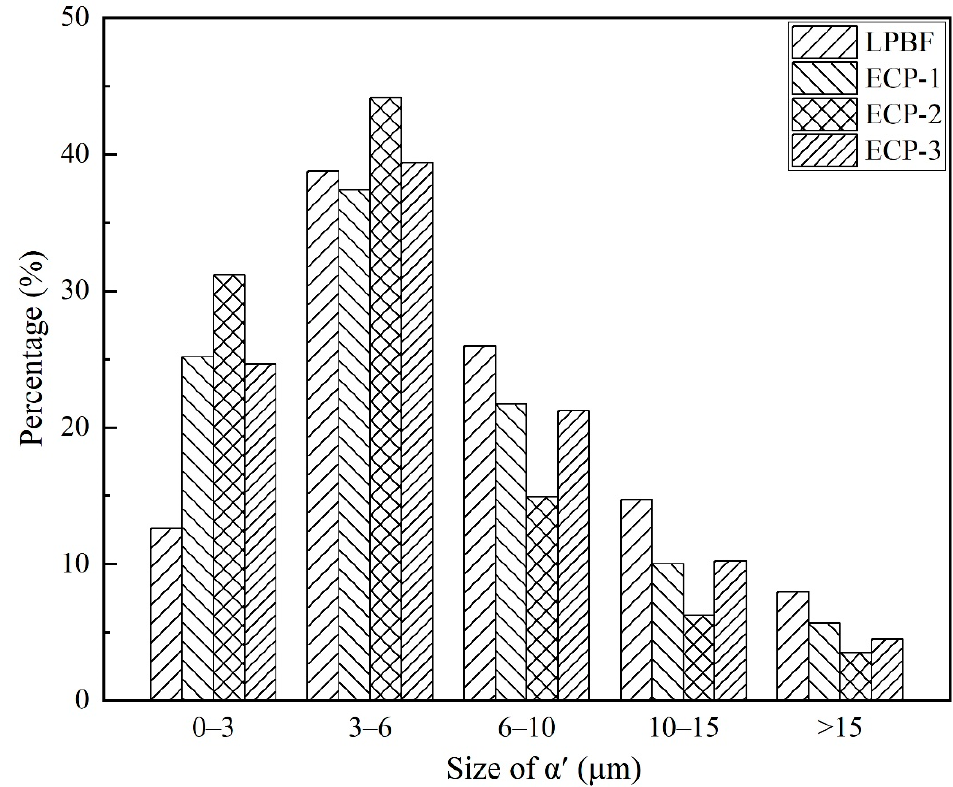
Figure 7. The size distribution of α′ martensites in the LPBF-Ti64 samples before and after ECP treatment. Table 7. The size distribution of α′ martensites in the LPBF-Ti64 samples before and after ECP treat- ment (%).